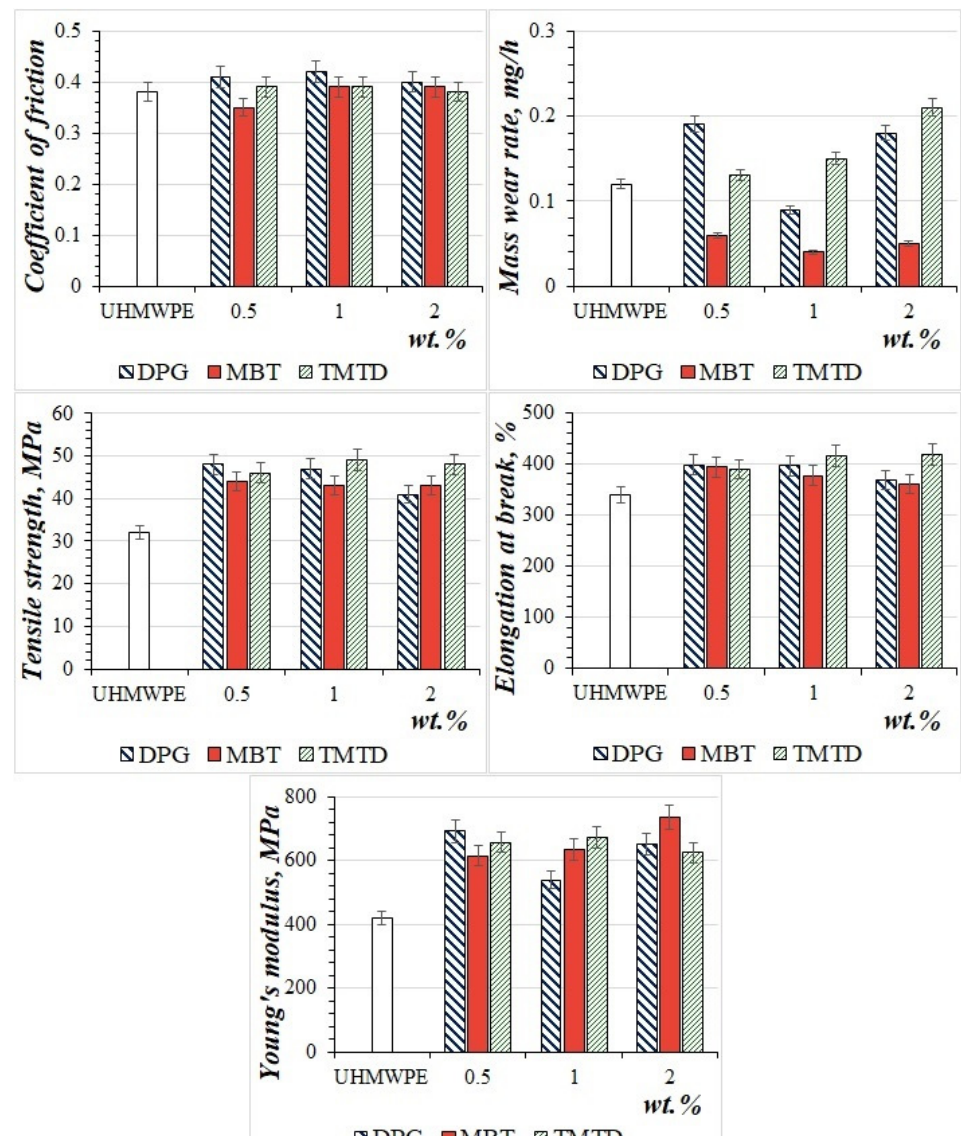
Figure 3. Deformation-strength and tribological properties of UHMWPE and PCM. Thus, the introduction of MBT, DPG, and TMTD into UHMWPE not only improves the mechanical properties but also oxidizes the polymer matrix, which can increase the interaction of the polymer with other